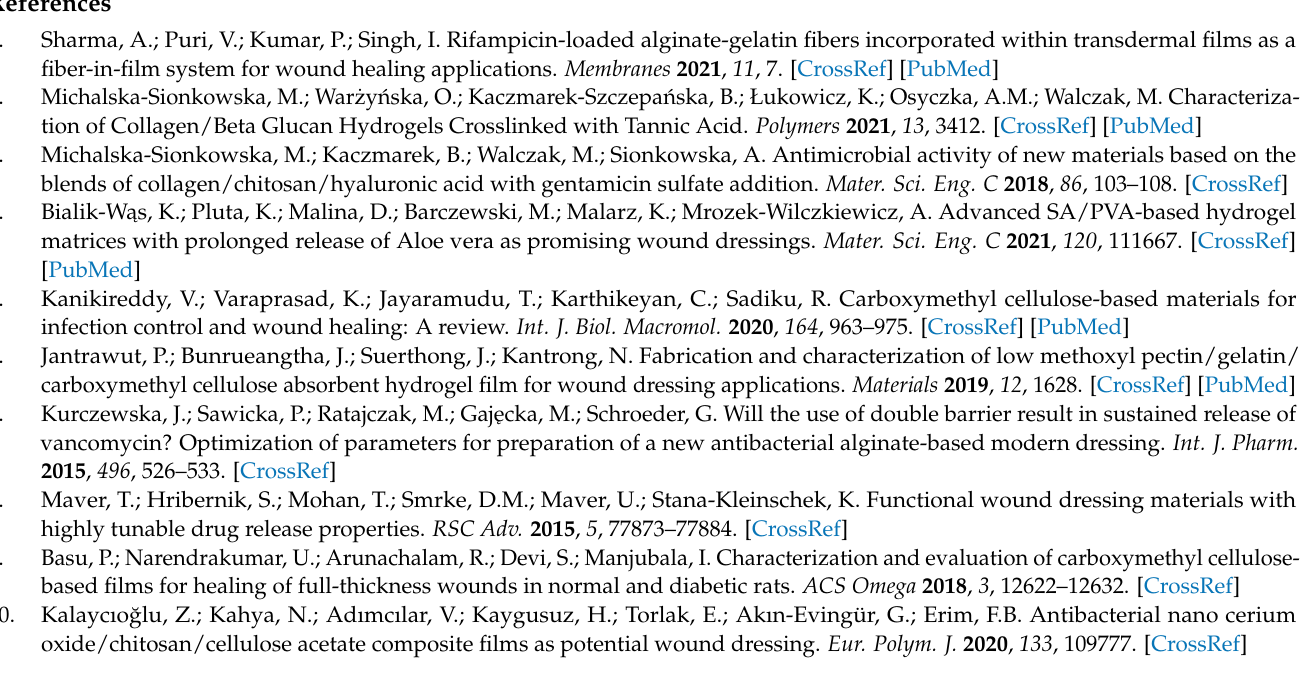
Films; Figure S2: Optical images of AMK loaded AX-CMC Films; Table S1: Major thermal degradation steps of the components and selected AX-CMC films; Figure S3: TG and DSC curve of glycerol (GLY); Figure S4: Optical images of the AX-CMC composite films at different time intervals during expansion experiment; Figure S5: Inhibition diameters of (a) Blank filter disk, (b) AX-CMC blank film, (c) AXC2A films, (d) AXC3A, (e) AXC4A and (f) AMK